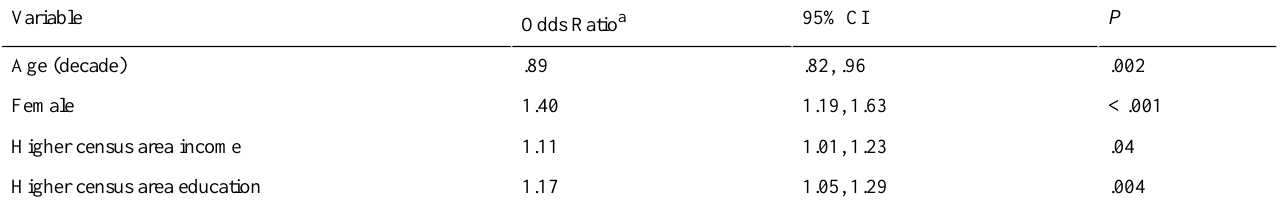
Table 3. Adjusted odds ratios for predicting a response to the MENU letter among invitees by age, gender, and census area income and education